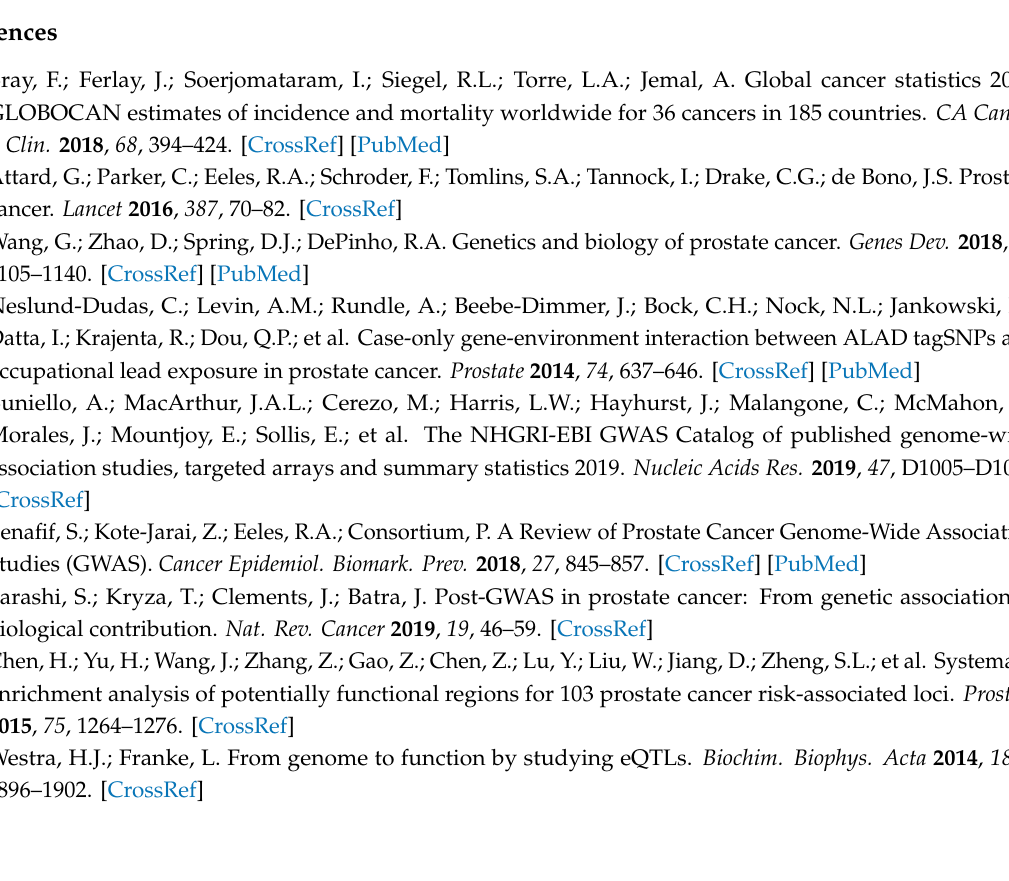
Figure S1: The correlation of log2 read count in overlapped SNPs between this study (903 SNPs) and previous SNPs-seq (374 SNPs). Figure S2: Distance of selected 348 SNPs to transcription start site (TSS) of the nearby genes. Figure S3: Functional annotations on the 348 SNPs visualized using circos plot. Figure S4: Validation of SNP rs7077275 by EMSA. Figure S5: Validation of SNP rs113082846 by EMSA. Figure S6: Association of RFS with combined expression value of CTBP2 and NCOA4 by log-rank test. Table S1: List of 903 SNPs, sequence read count, and BAB score. Table S2: Priority of SNPs selection based on BAB score. Table S3: Functional analysis of 348 significant SNPs using Regulome DB, HaploReg, SNPnexus, VEP, and MATCH datasets. Table S4: Functional annotations of three validated